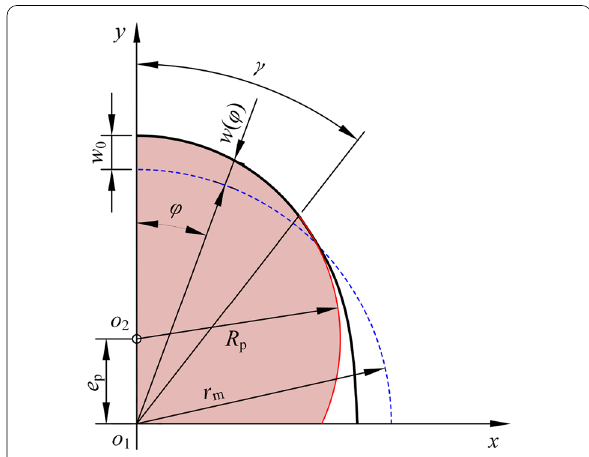
Figure 21 Schematic diagram of ring deformation under eccentric disc